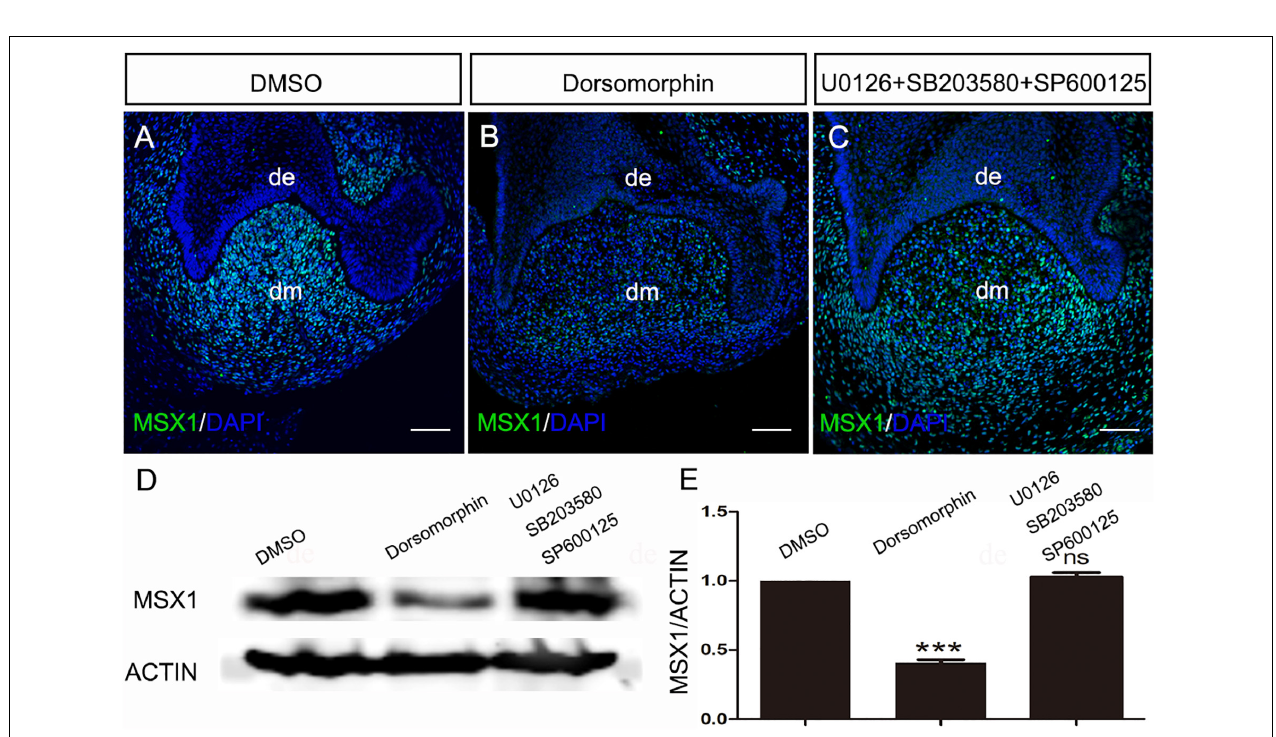
FIGURE 2 | Regulation of MSX1 expression is mediated by pSMAD1/5/8 in the human cap-stage tooth germs. (A–C) Immunostaining shows that MSX1 expression is abundant in dimethyl sulfoxide (DMSO)-treated human cap-stage tooth germs, dramatically reduced in dorsomorphin treated human cap-stage tooth germ, and unaltered in U0126 + SB203580 + SP600125 treated human cap-stage tooth germs. (D) A Western blot assay confirms the dramatically reduced expression of MSX1 in dorsomorphin treated human cap-stage tooth germs. Actin was used as the internal control. (E) Quantitative analysis of the Western blot assay. de, the dental epithelium; dm, the dental mesenchyme. Error bars represent SD. *** p < 0.001. Bar = 50 µ m.